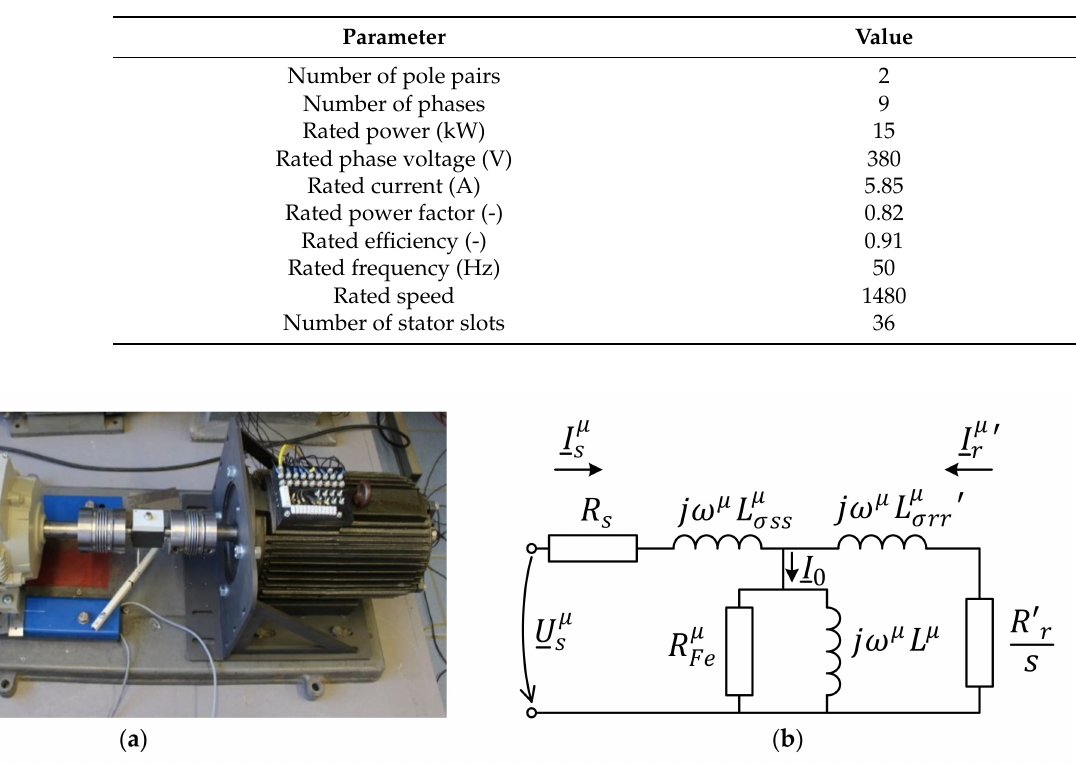
Figure 8. Measuring stand of a nine-phase induction machine and ( a ) the equivalent circuit, respecting different time harmonic components ( b